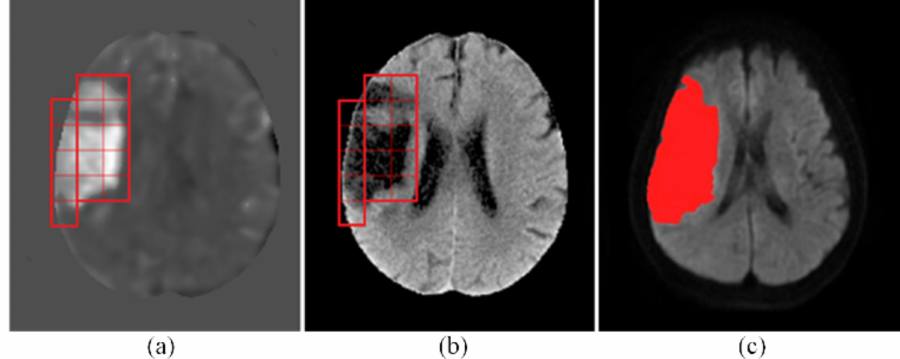
Figure 4. An exemplary result of infarct detection by the proposed CNN. ( a ) The detected infarcted patches were marked with red squares on the t-score map. ( b ) They were also marked on the intensity- transformed brain parenchyma image, i.e., the CT image after Step P5. ( c ) The red area on the MRI represents the detected infarcted region delineated by the experienced neurologist.